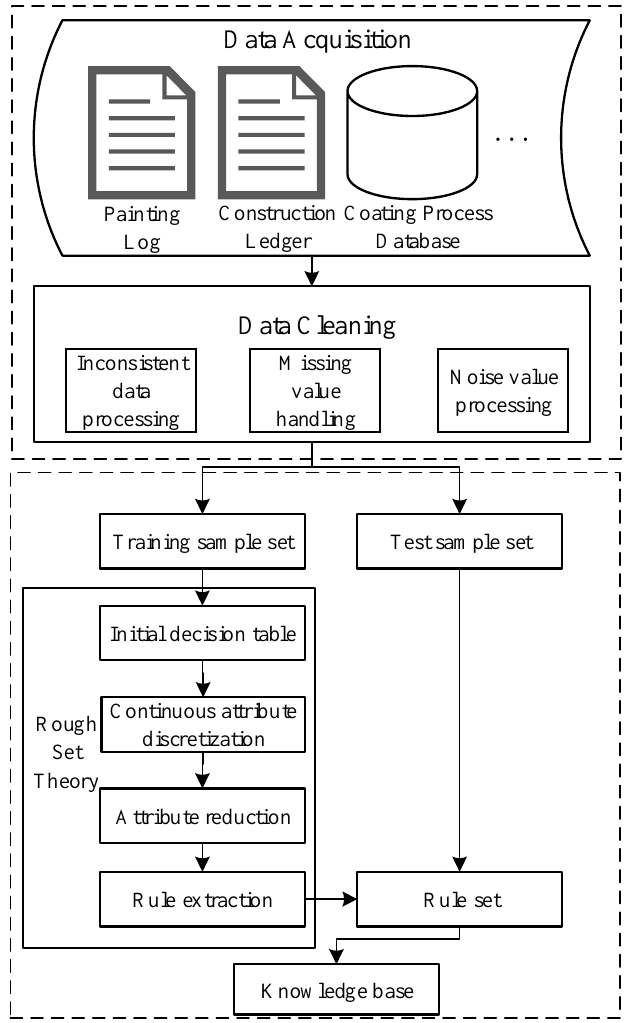
Figure 2. Knowledge acquisition process of ship painting defects based on rough set theory.